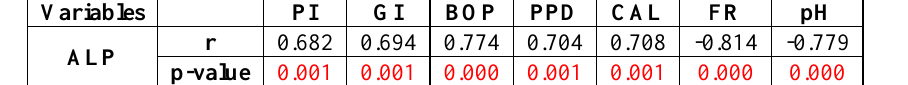
Table 6:Pearson’s Correlation Coefficient (r) between Clinical Periodontal Parameters (PLI, GI, BOP, PPD, CAL) and biochemical parameters(ALP) with FRandPHof themild group.